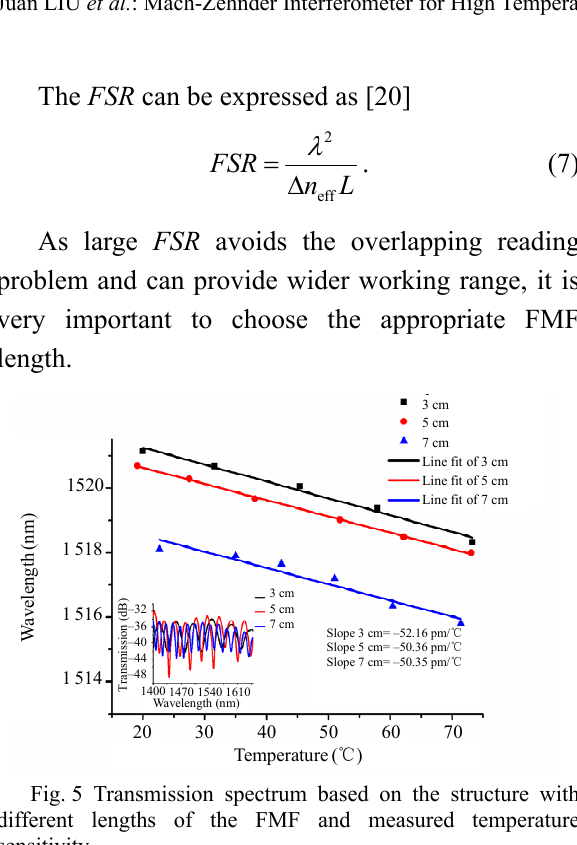
Fig. 6 Schematic diagram of the experimental configuration test platform for stress sensing.